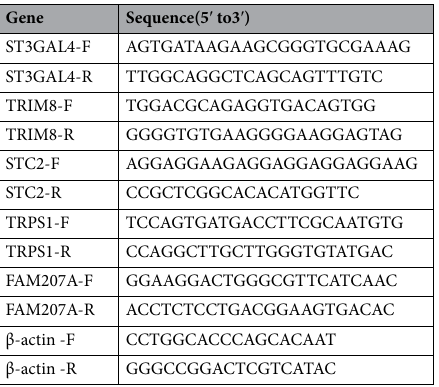
Table 1. The primer sequences used in the qRT-PCR